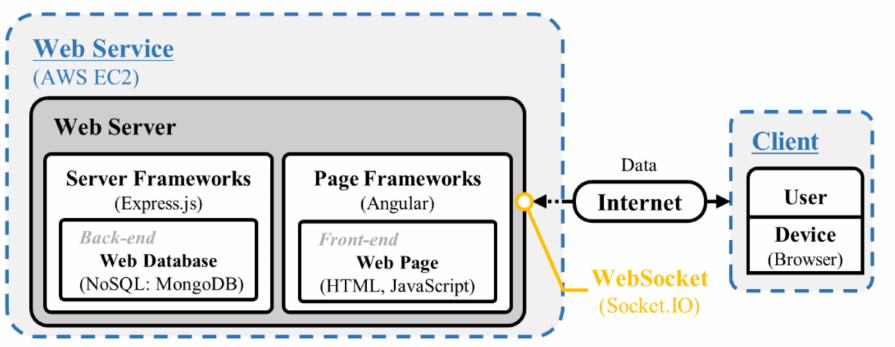
Figure 4. Configuration of the web